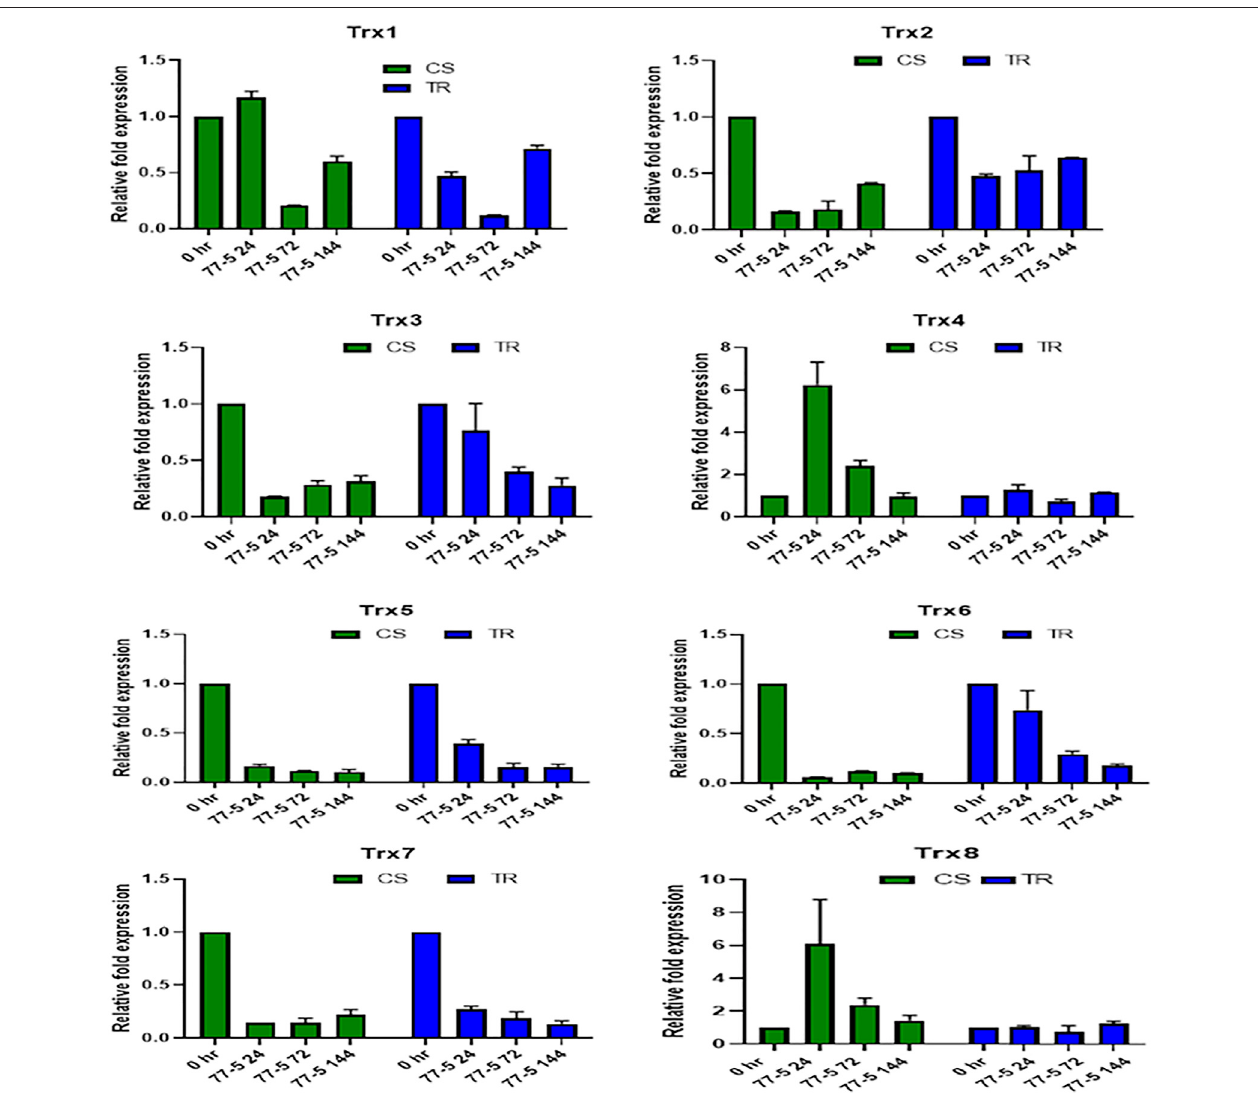
FIGURE 6| Expression analysis ofTrx family genes (Trx1, Trx 2, Trx 3, Trx 4, Trx 5, Trx 6, Trx 7, and Trx 8) in response toleaf rust inoculation. Chinese spring (CS) and introgression line of leaf rust resistance gene (Lr9) in CS, Transfer (TR). Leaf rust pathogen Puccinia triticina Eriks Pathotype 77-5 (121-R-63) uredospores were inoculated on 10 days old wheat seedlings and kept in a humidity chamber for 24 h. Leaf samples for qRT-PCR analysis were collected at 0 h after inoculation (HAI), 24 HAI, 72 HAI, and 144 HAI. Values are mean (±SE) of three biological replicates.